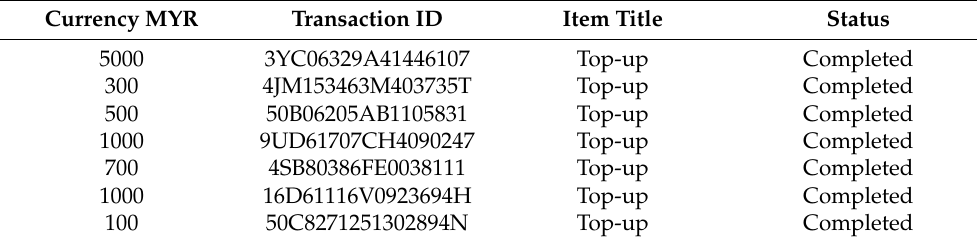
Table 6. Top-up transaction